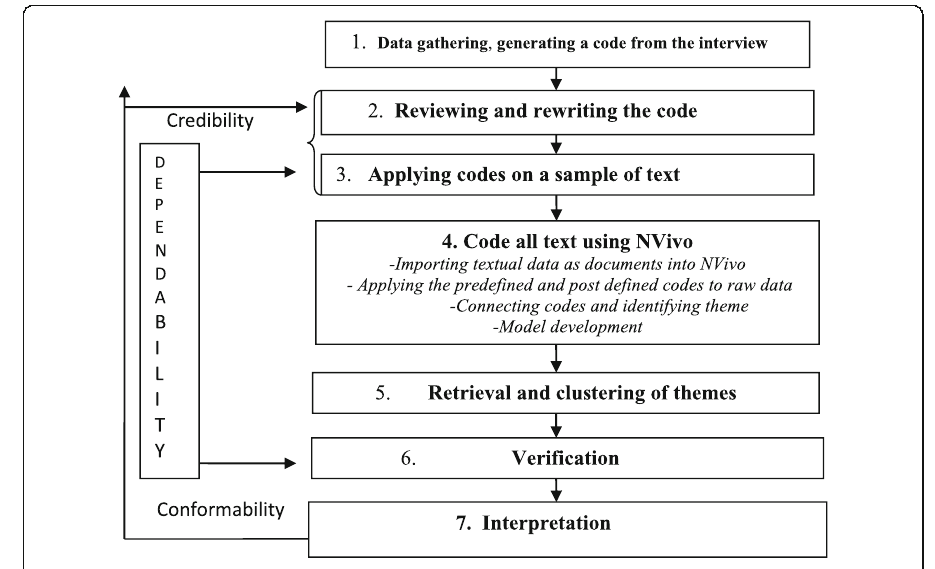
Fig. 1 Data Analysis